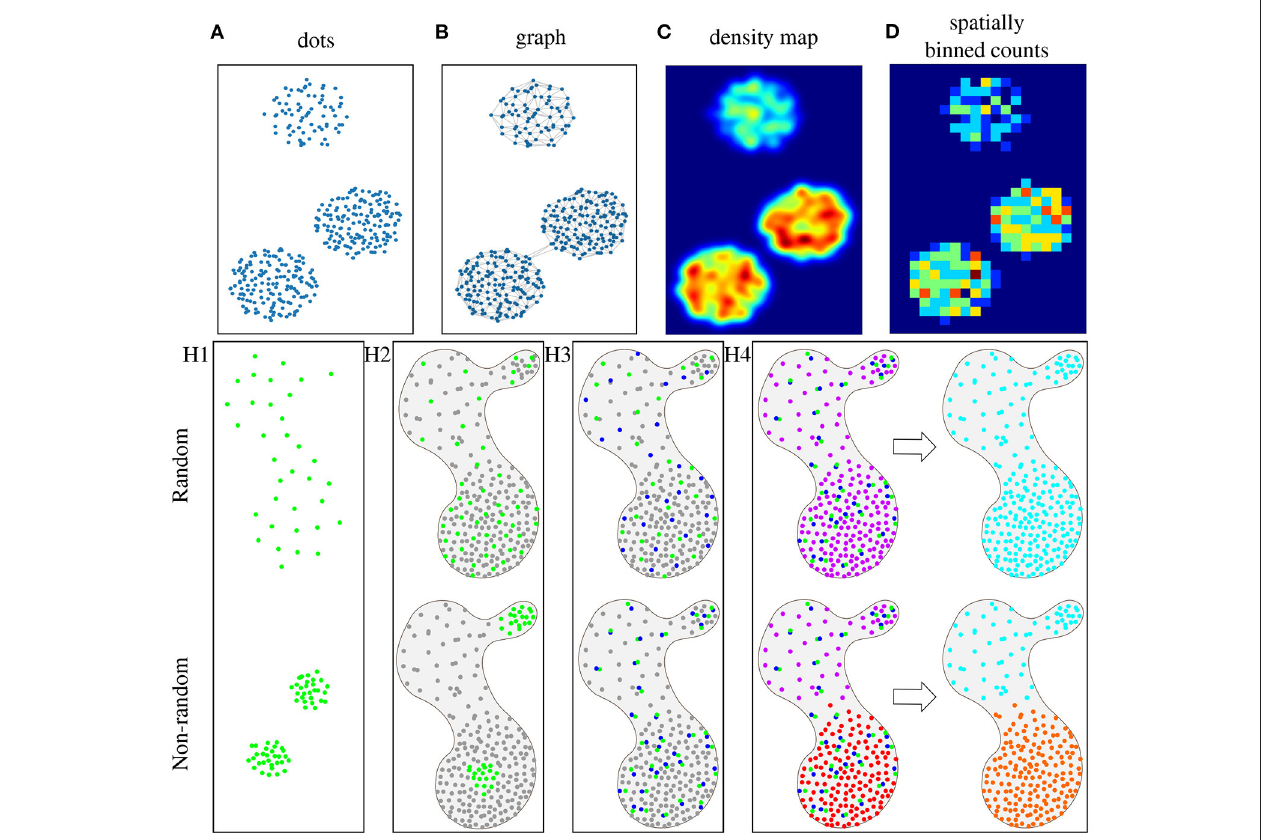
FIGURE 1 | Schematic representations of objects, such as cells or mRNAs, in microscopy images, where each dot represents an object, and the color reflects the object type (where gray is an unspecified type). (A) Simple representation, where each dot has a specific location in 2D tissue space. (B) The same data represented as a graph, where each dot is a node, and nodes are connected based on a maximum distance criterion. (C) Dots can also be represented by a probability density map, where warmer colors represent more dense dots, or (D) as counts in fixed spatial bins. Here, bins are squares and warmer colors represent higher object counts per bin. Spatial statistics are used to prove four different hypothesis (with the top row representing the random case): (H1) Visualization of hypothesis H1: Objects of type A (green) are non-randomly distributed. (H2) Visualization of hypothesis H2: Objects of type A (green) are non-randomly distributed as compared to the distribution of other objects (gray) in the same tissue sample. (H3) Visualization of hypothesis H3: Objects of type A (green) and B (blue) are non-randomly distributed in relation to one another within the distribution of other objects (gray) in the same tissue sample. (H4) Visualization of hypothesis H4: There are groups of object types (multiple colors in “niches”) that are non-randomly distributed within the tissue sample.